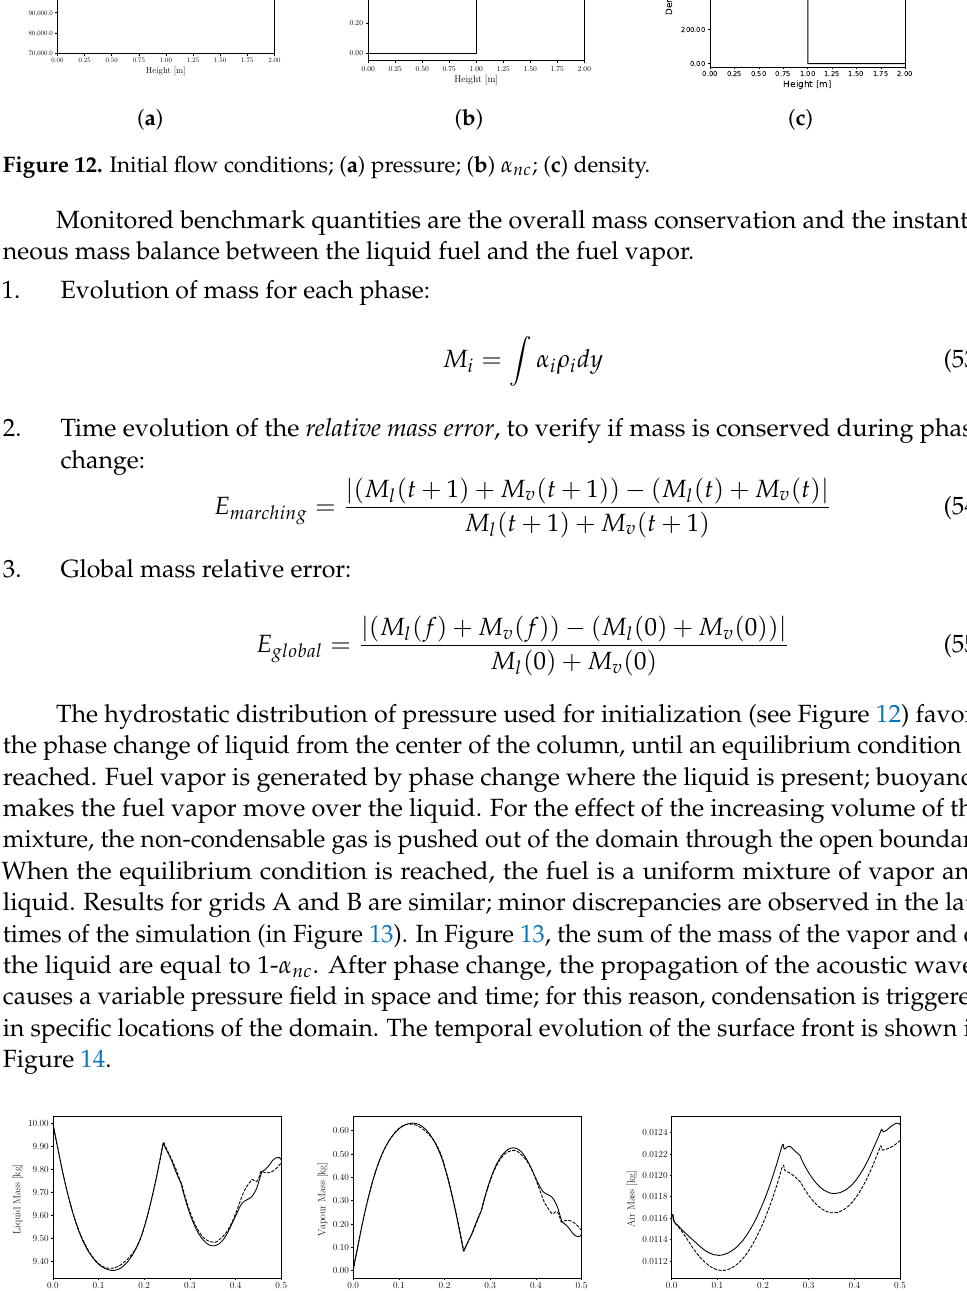
640 cells); ( ) grid B (1 1280 × ×